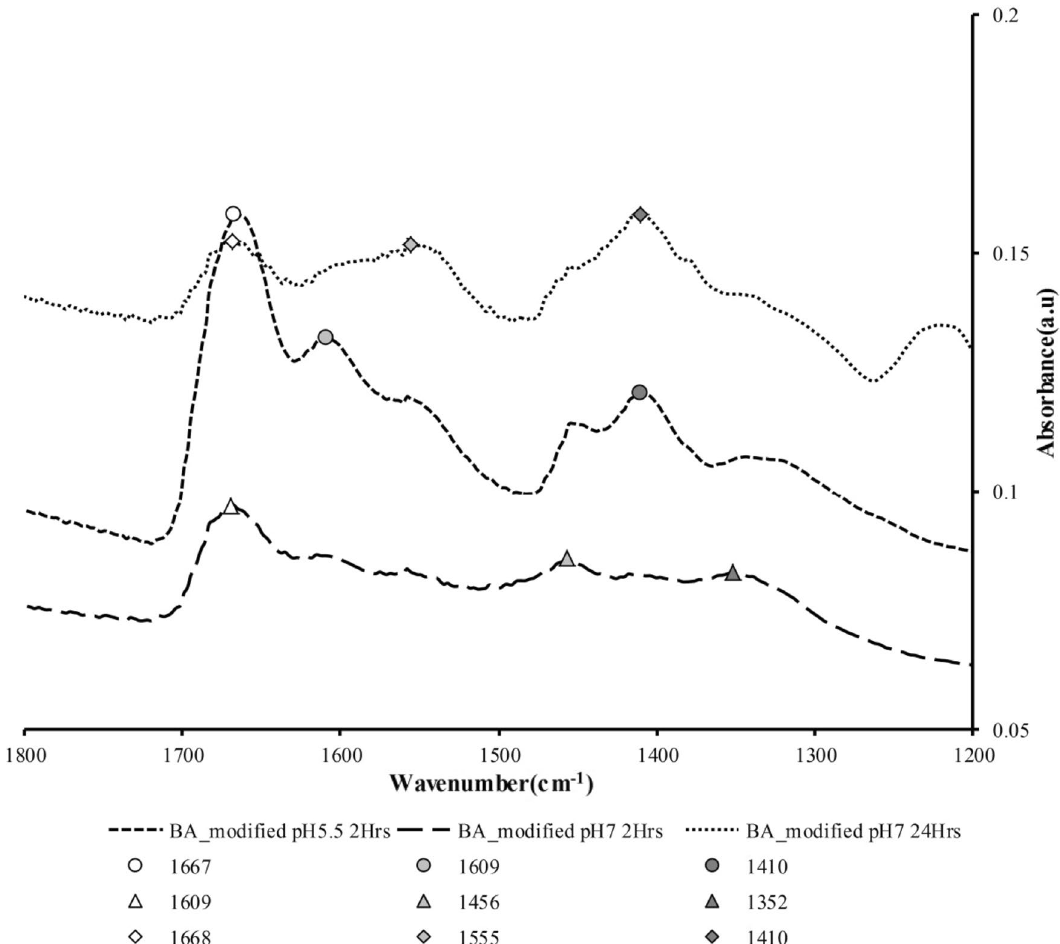
Figure 6. Modified CuONPs by using butyric acid as the reagent ( a ) open circle BA_modified at pH 5.5 for 2 hours, ( b ) open triangle BA_modified at pH 7 for 2 hours and ( c ) open diamond BA_modified at pH7 for 24